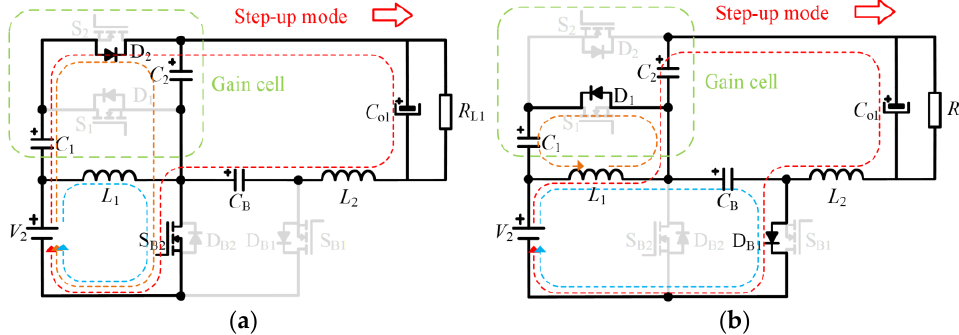
Figure 3. The equivalent circuit of the operation modes in step-up mode: ( a ) S B2 on; ( b ) S B2 off.